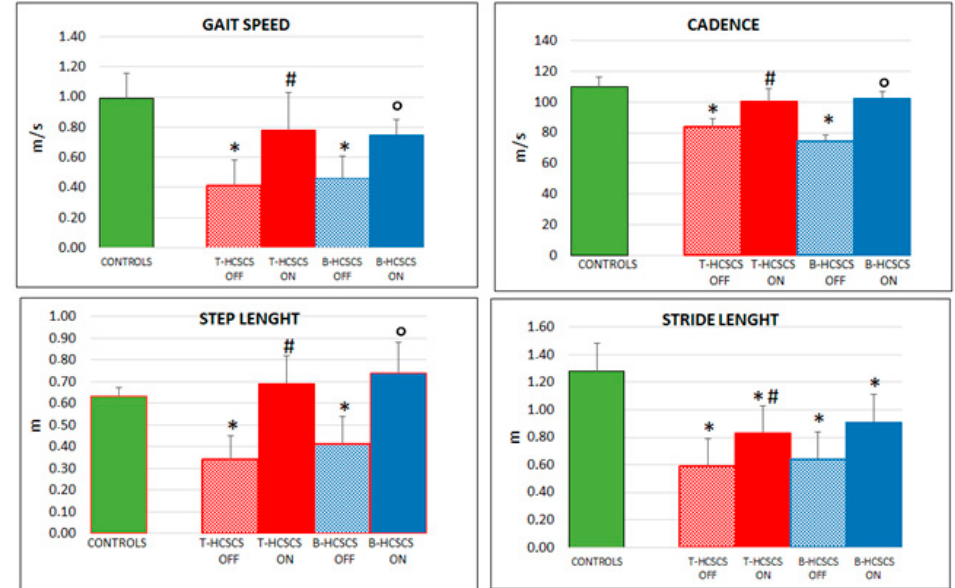
Figure 5. Improvement of spatiotemporal gait parameters (gait speed, cadence, step length, stride length, step width, swing speed, stance duration, double support) in the two groups of patients investigated at six months under T-HCSCS ( red ) or B-HCSCS ( blue ). * p < 0.05: Control vs. T-OFF and B-OFF; # T-OFF vs. T-ON; ° B-OFF vs. B-ON (except cadence: p < 0.001) and stance duration (not significant). Statistics were assessed by Mann–Whitney tests. 3.2. B-HCSCS (Group II Patients) The best clinical motor outcome was obtained by delivering bursts at 40 Hz, with each burst composed of five 1 ms pulses delivered at 500 Hz and at 0.5 ± 0.2 mA current intensity.